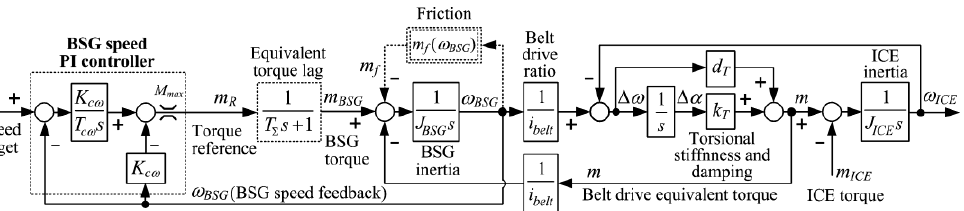
Figure 7. Block diagram of electrical servomachine speed control system with fast inner current/torque control loop embedded within the frequency converter.